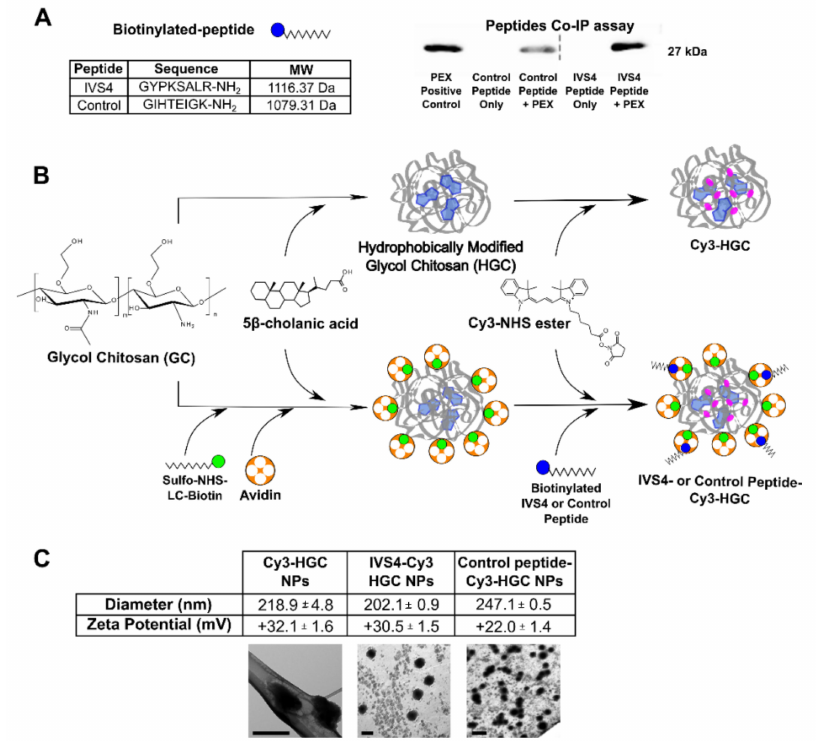
Figure 1. IVS4 peptide is specific for the MMP-14 hemopexin domain: ( A ) A modified pulldown using the biotinylated IVS4 peptide or control bound to streptavidin beads after incubation with or without purified MMP-14-hemopexin-like domain (PEX) demonstrates that IVS4 peptide binds significantly more PEX than control peptide. Dashed line indicates where another tested condition not discussed herein has been cropped out. Synthesis of peptide-functionalized nanoparticles: ( B ) Glycol chitosan is first coupled with biotin, followed by binding with avidin. Hydrophobic modification is performed via reaction with 5 β -cholanic acid to yield a micellar nanoparticle. Biotinylated peptides (IVS4 and control peptides) are incorporated into the nanoparticle via the biotin-avidin binding, and Cy3 fluorophore is conjugated to the backbone of glycol chitosan. As control, a similar synthesis protocol is performed to obtain plain, non-peptide-functionalized nanoparticles. Physico-chemical and morphological features of the synthetized nanocomplexes: ( C ) TEM images confirmed the formation of spheroid-like nanoparticles. Dynamic light scattering and zeta potential analyses revealed homogenous sizes and positively charged surfaces. Scale bars, 500